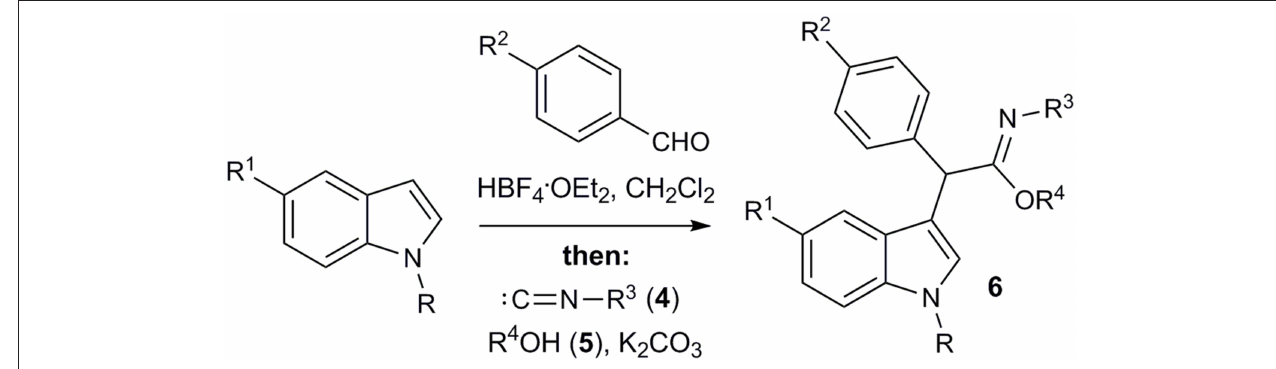
FIGURE 5 | Consecutive four-component synthesis of imidates 6